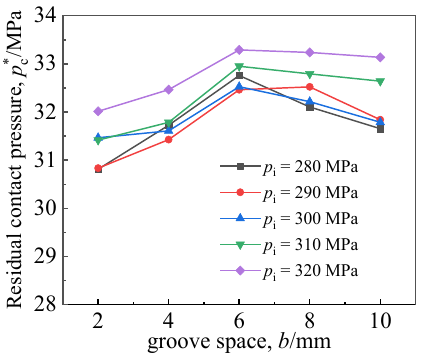
Figure 18. Effects of groove space on residual contact pressure of joints.